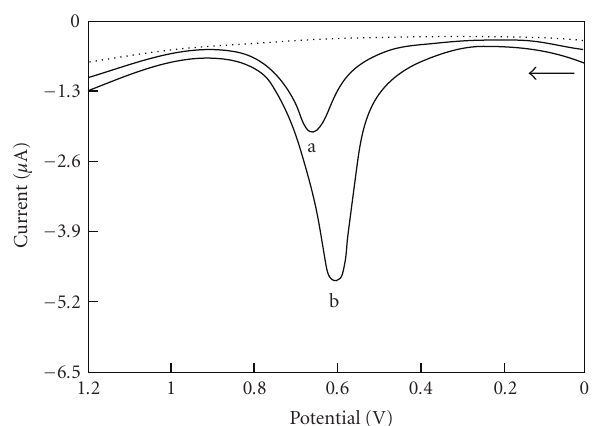
Figure 2: Comparison of square wave voltammograms for 2000 ng/mL of salbutamol at bare electrode (peak a) and SWNT- modified electrode (peak b) at pH 7.2 and background PBS (1M) at SWNT/EPPGE ( ...